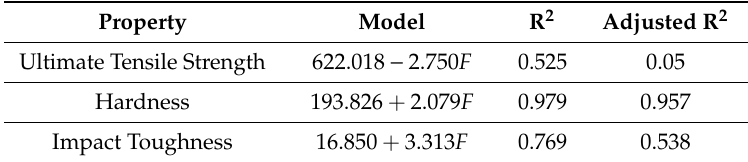
Table 22. Model summary for the mechanical properties of martensitic stainless steel in terms of ferrite composition.